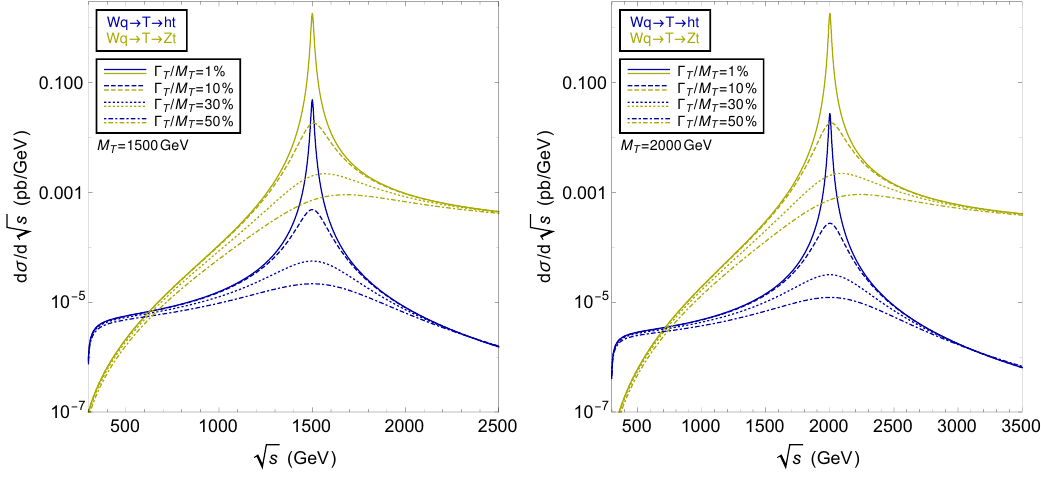
Figure 4 . Partonic cross section for the Wq → ht (blue) and Wq → Zt (yellow) processes, that both proceed via the s -channel exchange of a vector-like quark T . We depict the dependence of the √ cross section on the partonic centre-of-mass energy s , for different values of the Γ T /M T ratio. We consider vector-like quark setups with M = 1500 GeV (left panel) and 2000 GeV (right panel), T and chiralities of the T couplings that are chosen left-handed and fixed as in eq. (3.7) to reproduce the branching ratio relation of eq.